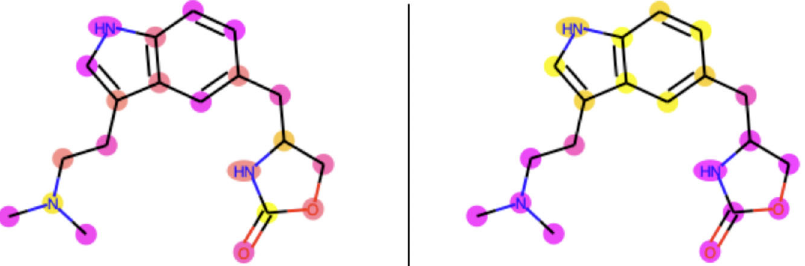
Fig. 19 Example of improved explanation quality due to adversarial training. Molecule attribution heat maps are generated using the vanilla gradients technique. Yellow indicates higher importance and pink indicates lower importance. Note that the molecular importance explanations are sparse before adversarial training (left) and become more compact and physically meaningful after adversarial training (right). Figure reprinted from ref. 44 with